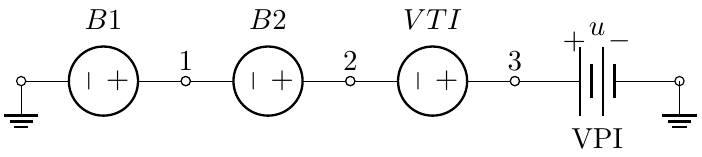
Figure 2. Circuit equivalent to equation with a = 0.